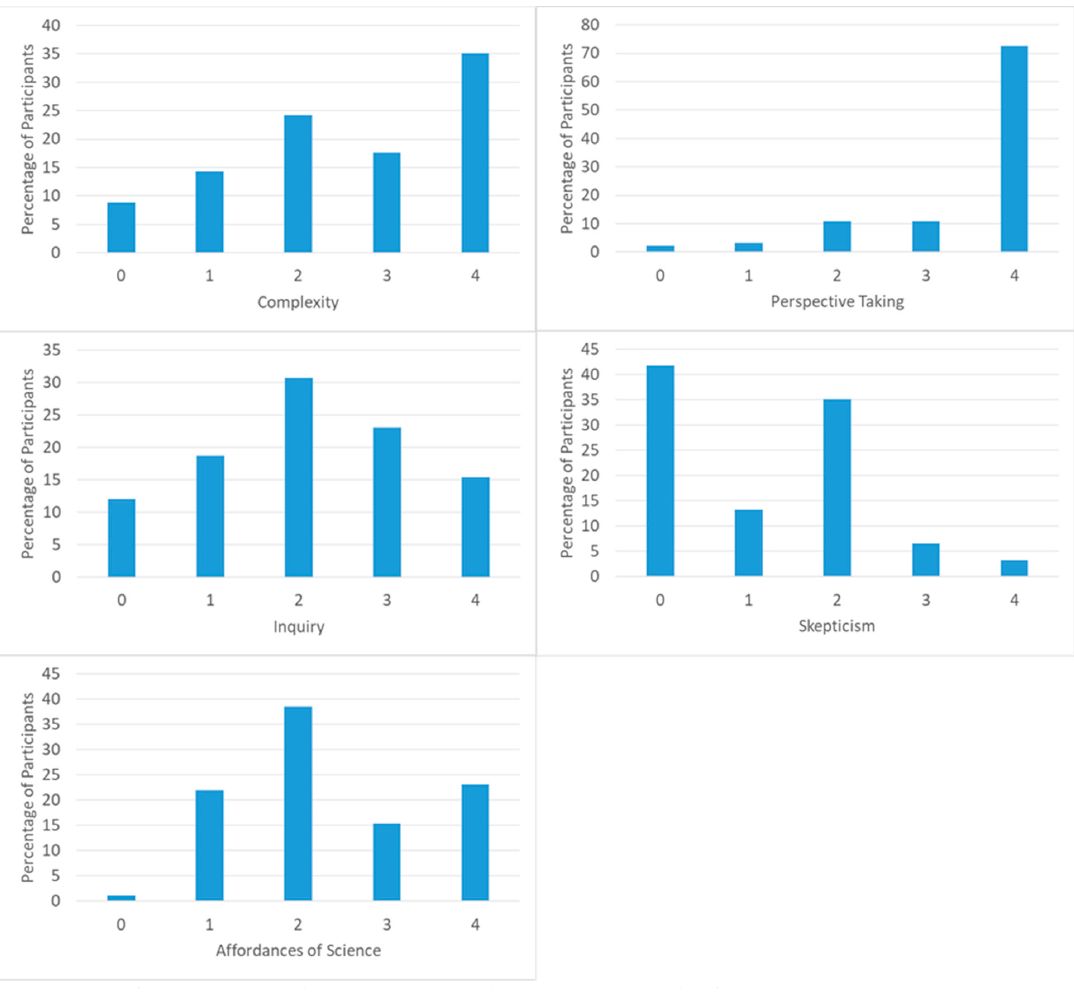
Table 3. Percentage of responses scoring at each level and the mean score for dimensions of SSR.